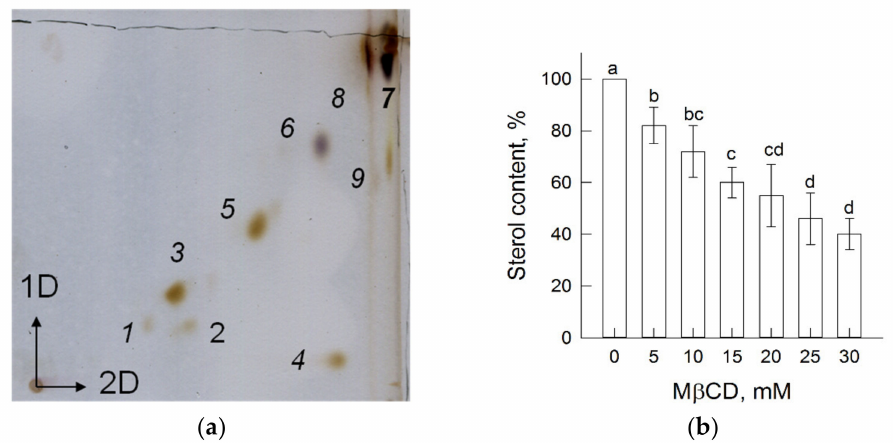
Figure 1. Two-dimensional thin layer chromatogram of total lipids ( a ) and sterol content ( b ) of plasma membrane vesicles treated with different M β CD concentrations. Arrows in ( a ) indicate the first and the second directions of separation. The numbers correspond to 1 —phosphatidylinositol; 2 — phosphatidylserine; 3 —phosphatidylcholine; 4 —phosphatidic acid; 5 —phosphatidylethanolamine; 6 –cerebrosides; 7 , 8 —sterols (steryl glycosides and acylated steryl glycosides); and 9 —free fatty acids. The bars in ( b ) represent mean ± SD of two to five independent biological replicates. The initial level of sterol content (85.6 ± 8.6 µ g mg − 1 protein) corresponds to 100%. Means with different letters represent significant differences ( p < 0.05) by Tukey’s